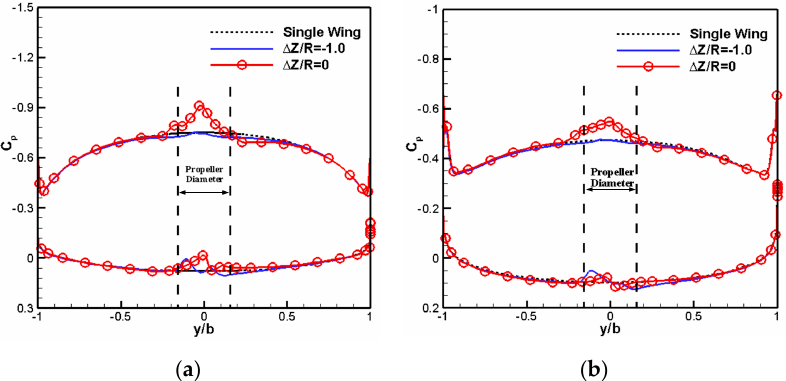
Figure 7. Spanwise pressure distribution of the wing: ( a ) x / c = 0.25; ( b ) x / c = 0.5. ( Ma = 0.1017, α = 2 ◦ ,